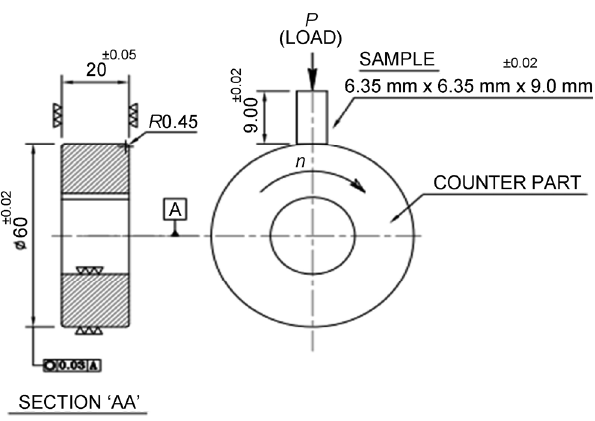
Fig. 1 Schematic presentation of the block on the ring wear test. using a diamond slurry of grit size 6 μ m with white kerosene oil as a suspension media on a rotating velvet cloth. Samples were cleaned in hexane prior to the wear test. The gap between the static block sample and the counter face of the roller was maintained as 2 mm for each experiment. After each test roller was polished using a silicon carbide emery paper of different grit sizes: 100, 400 and 1,000 μ m they were